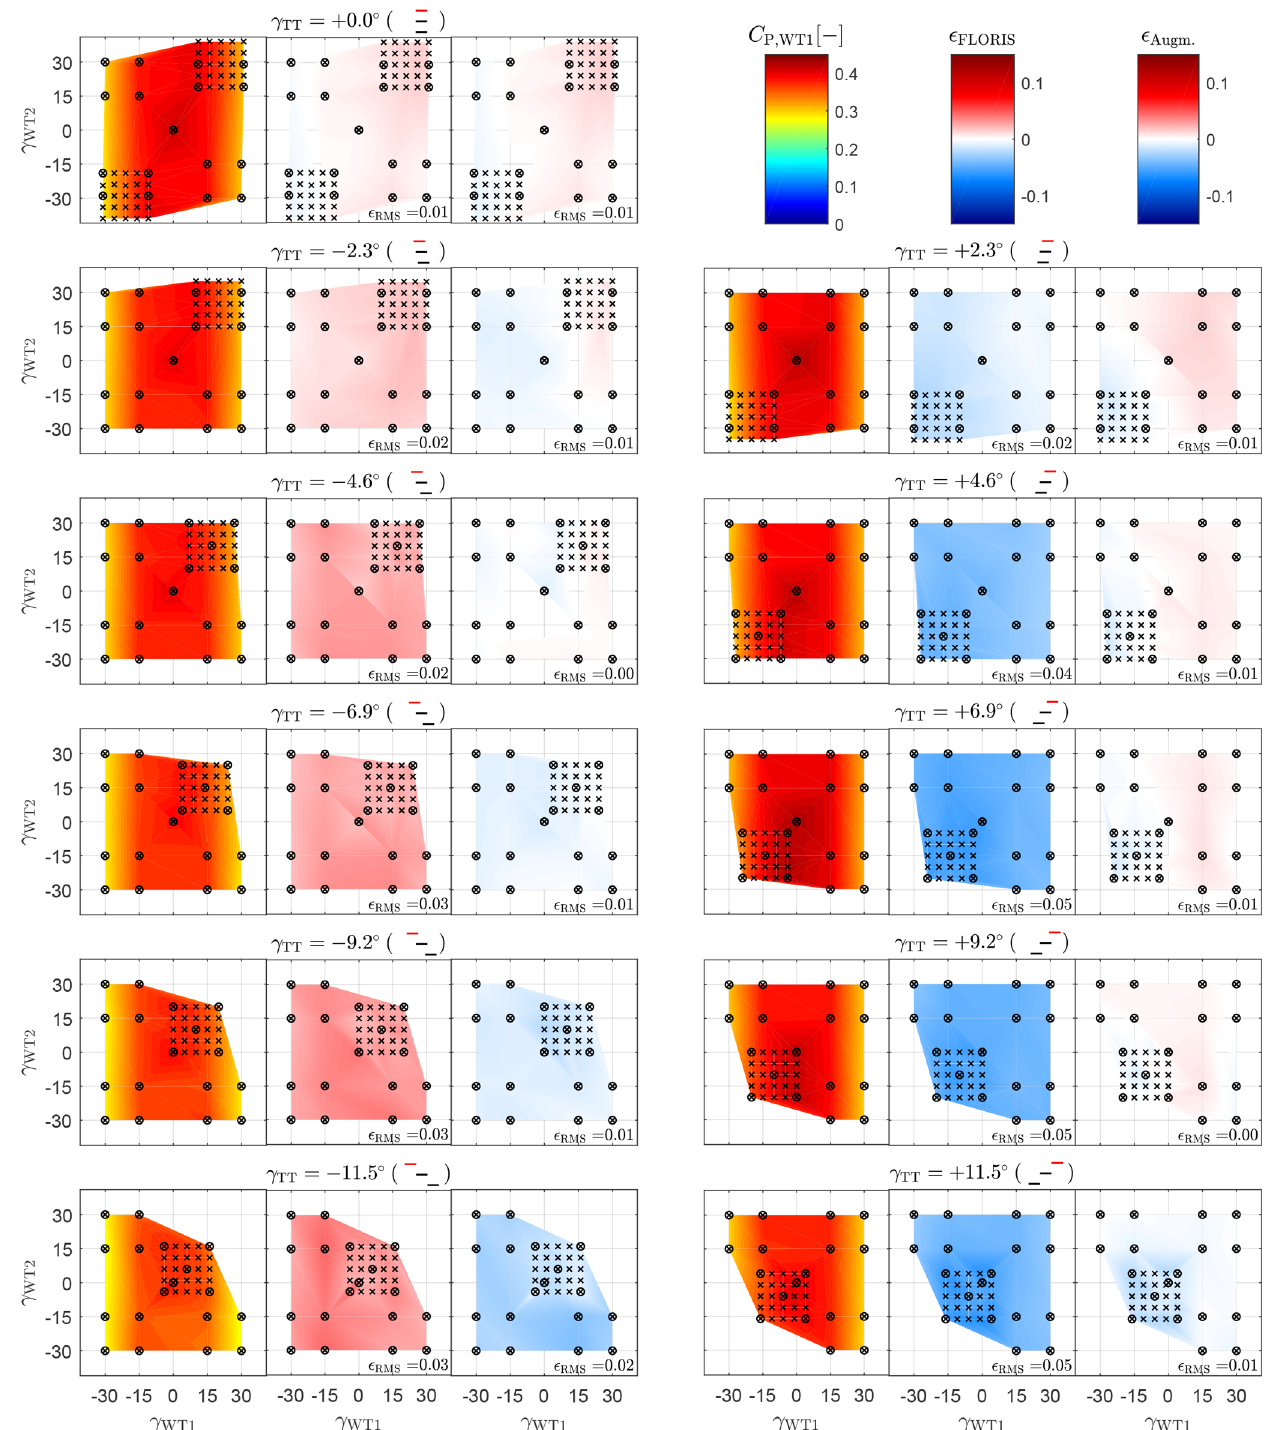
Figure A1. Wind turbine WT1. Each cluster of three subplots represents a unique turntable position, as indicated by the title and the wind farm layout sketch. Left subplot: turbine power coefficient C P , WT1 as a function of γ WT1 ( x axis) and γ WT2 ( y axis). Middle subplot: FLORIS model error. Right subplot: augmented model error. Cross symbols: all measured configurations. Circles: conditions used for parameter